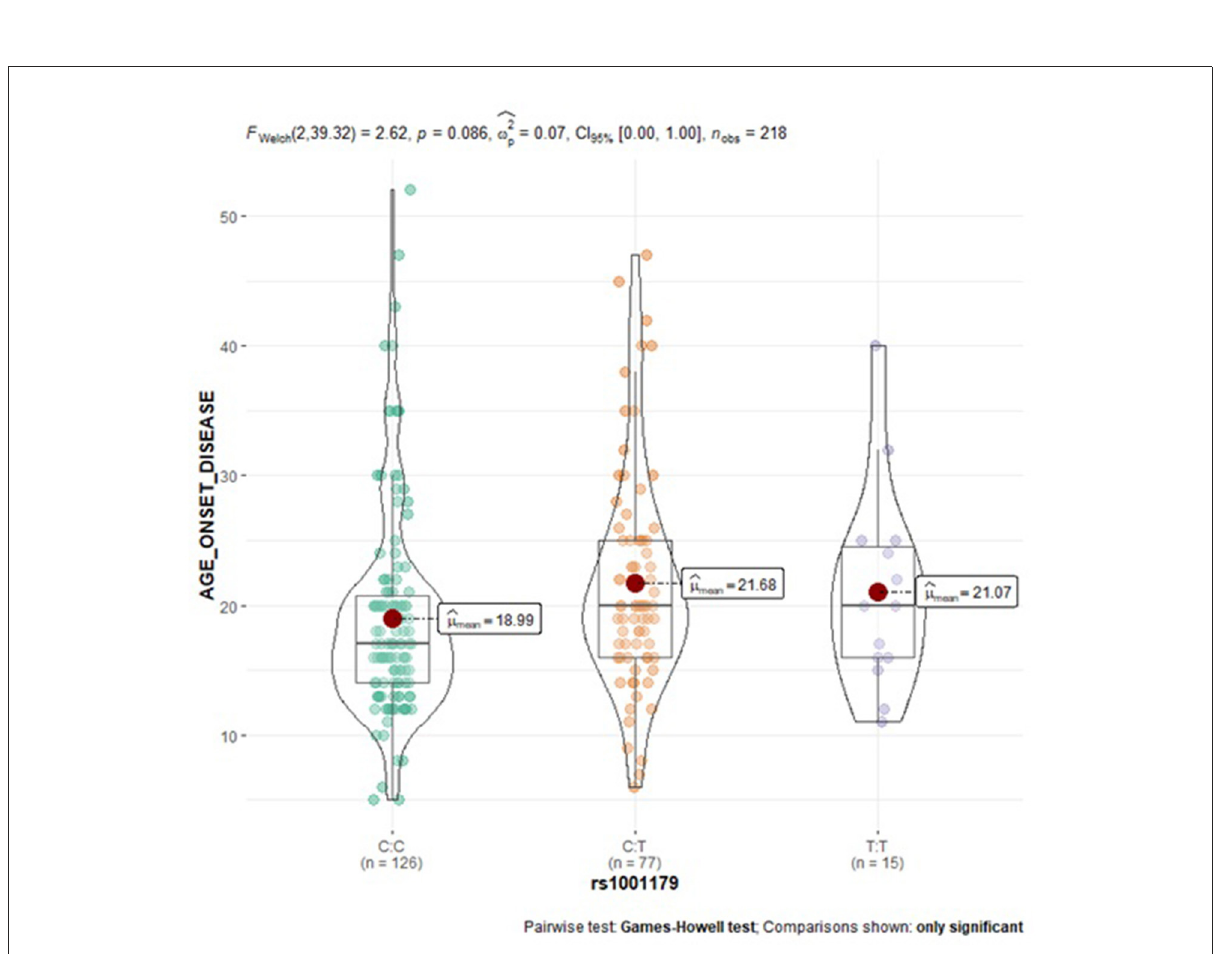
FIGURE2 Violin plots displaying the mean age at disease onset according to CAT rs1001179 genotype profile in migraine